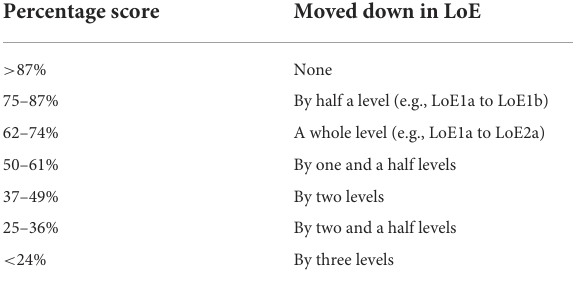
TABLE 2 Movement of level of evidence based on percentage scored in quality